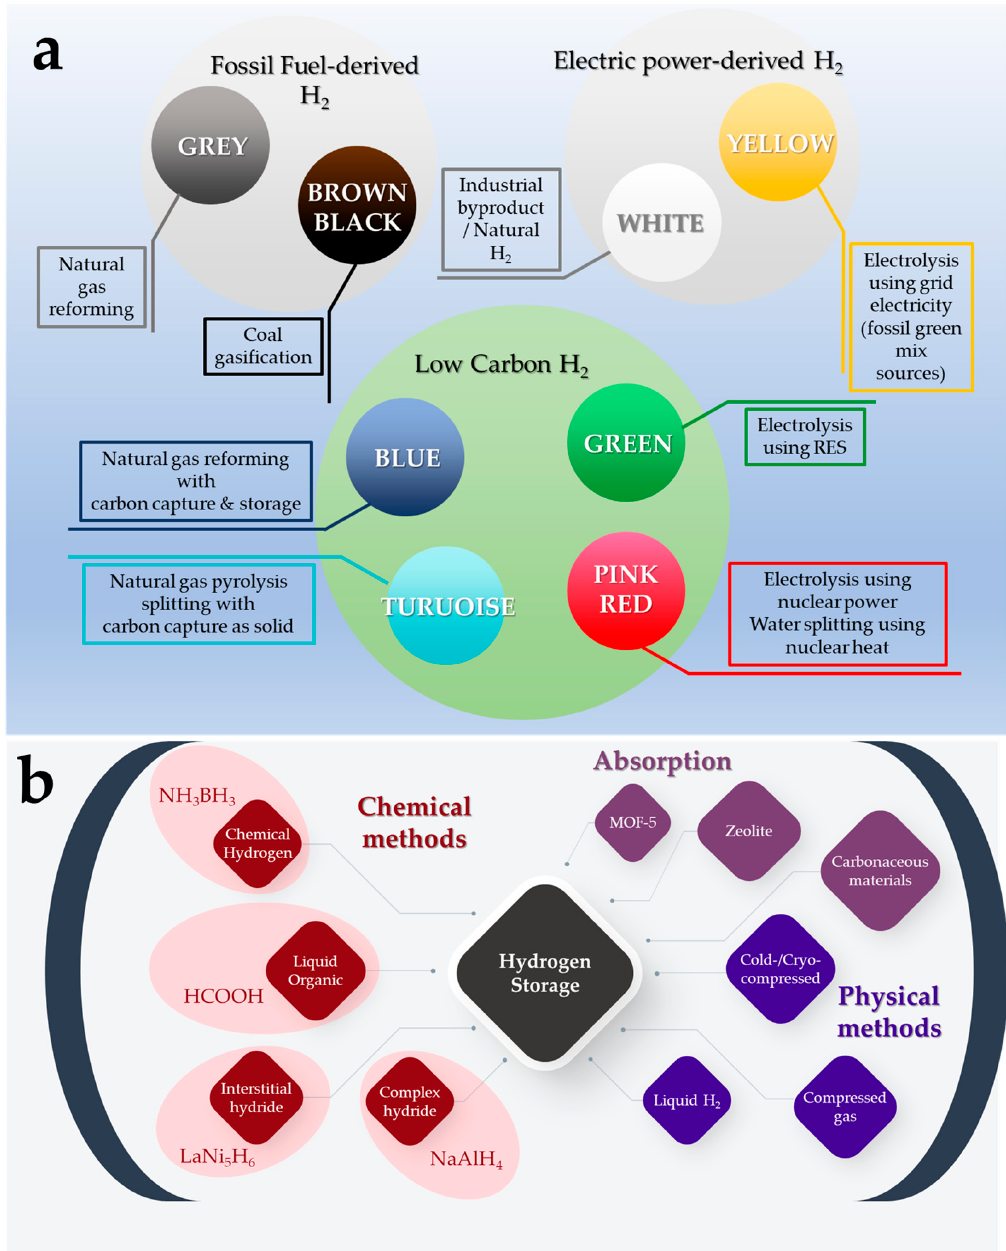
Figure 2. ( a ) Color classification of H 2 based on the means of production ( b ) Hydrogen storage methods.